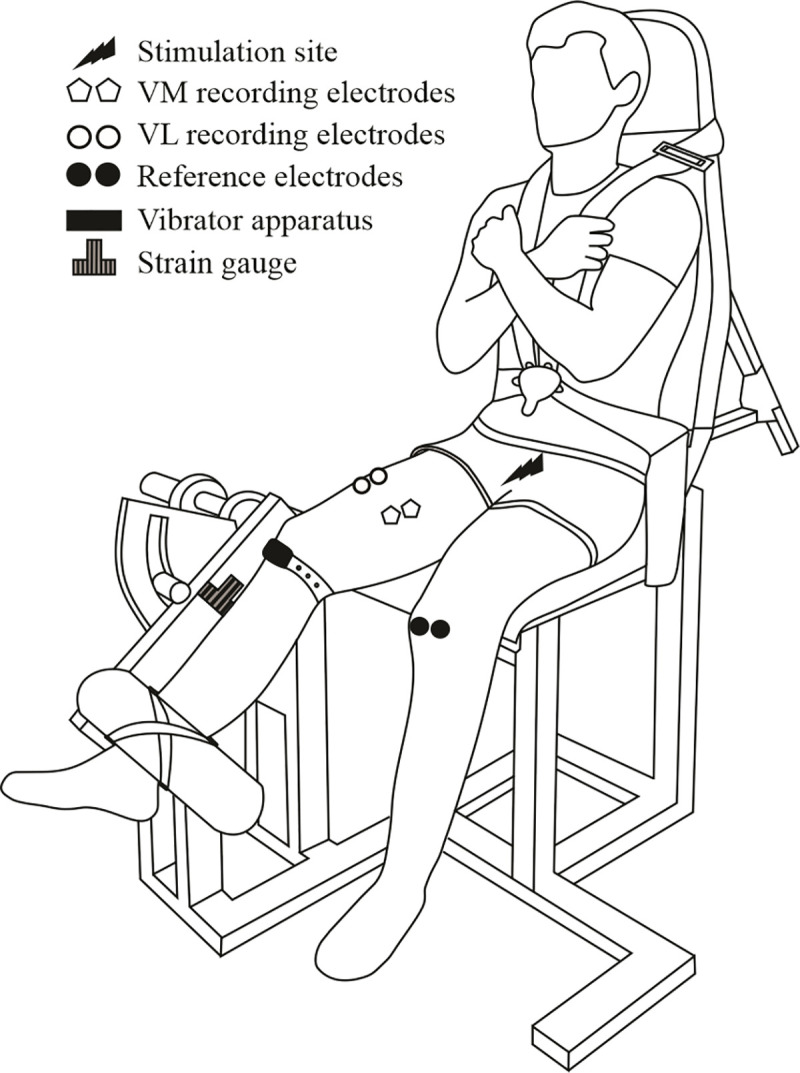
Illustration of experimental setup used during neuromuscular assessment and fatiguing exercise for the experimental session in which the individuals were tested at 150° knee angle.VL: Vastus Lateralis; VM: Vastus Medialis.